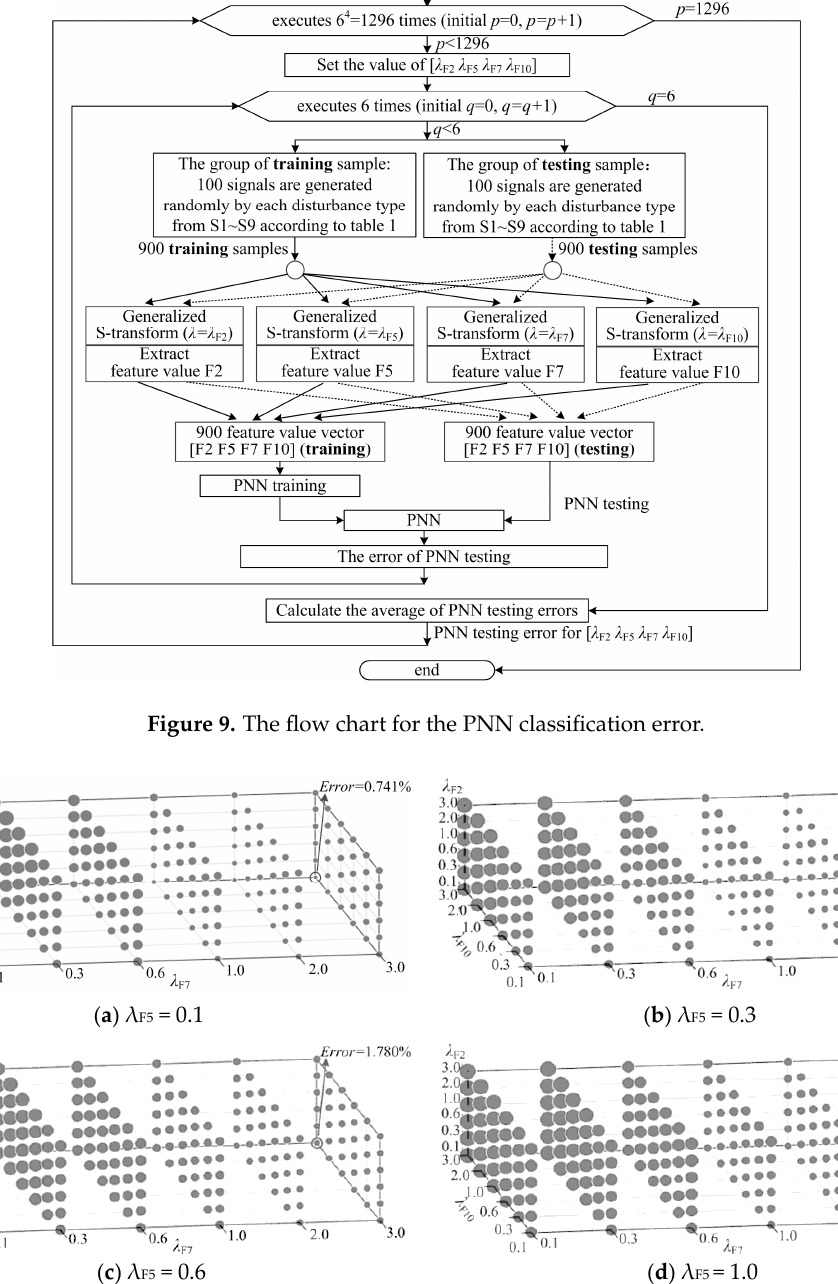
Figure 9. The flow chart for the PNN classification error.